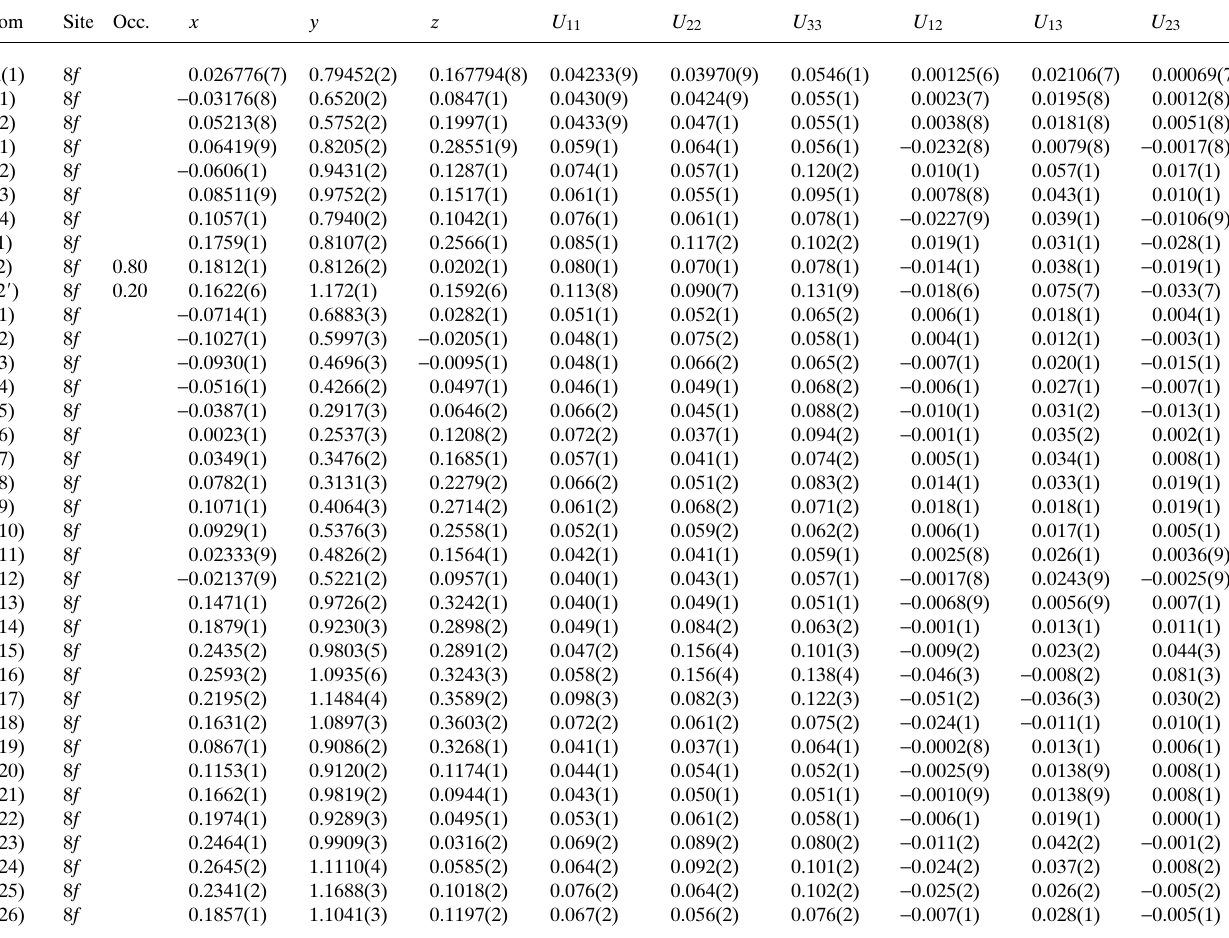
Table 3. Atomic coordinates and displacement parameters (in Å 2 ) .